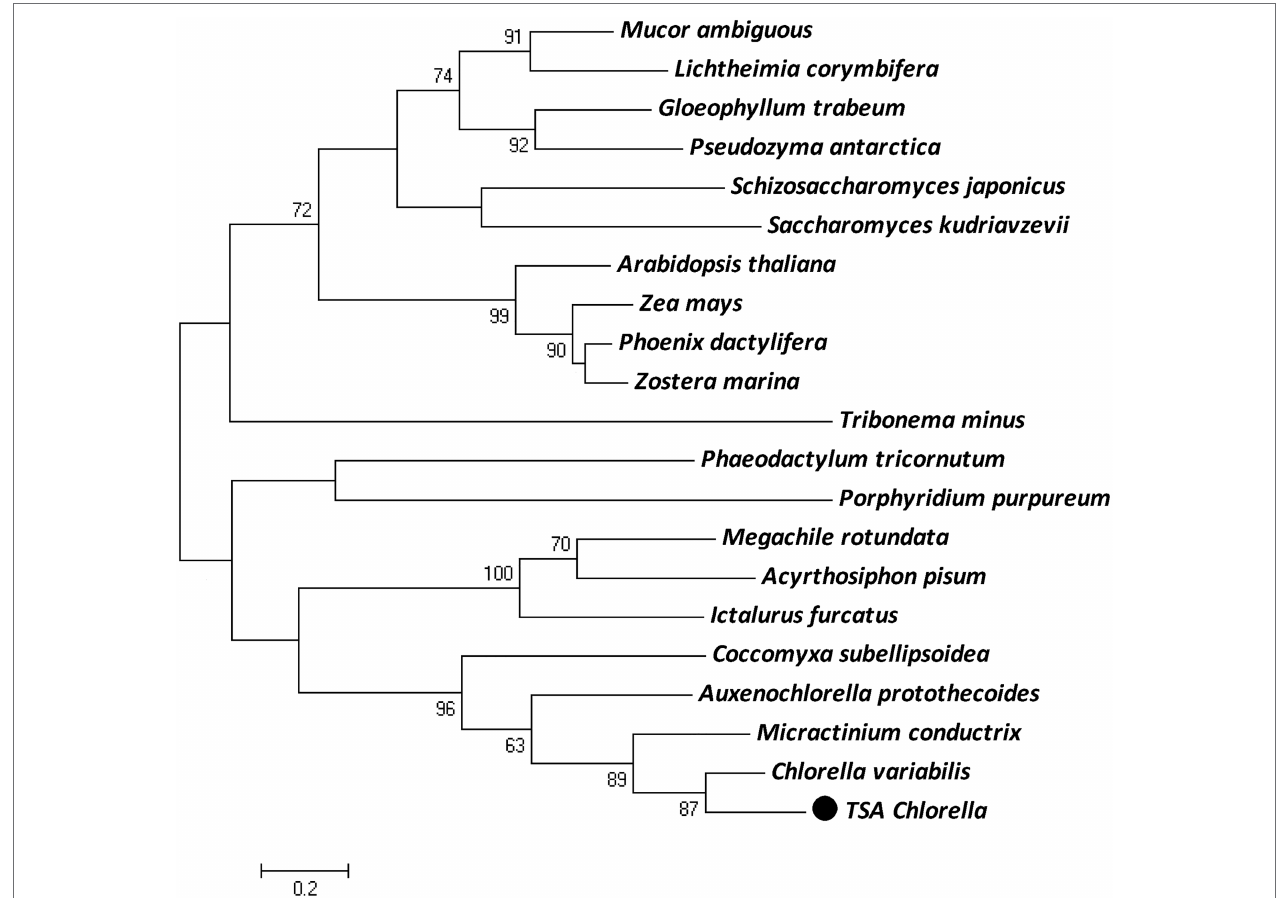
FIGURE 2 | The maximum-likelihood (ML) phylogenetic relationships of PAP proteins between TSA Chlorella sp. and those of other species. Bootstrap values were calculated 1,000 times, and values below 50% were not included. The TSA Chlorella sp. is indicated by boldface in a box.